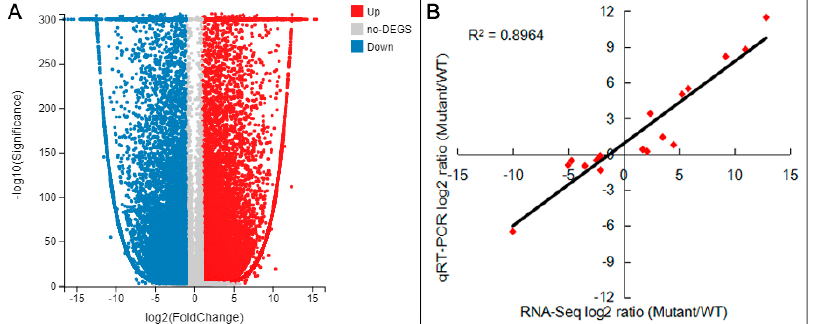
Figure 7. Analysis and validation of differentially expressed genes (DEGs) between ‘SO’ and ‘ZH’. ( A ) Volcano plot of DEGs. The X axis represents log2 transformed fold change; the Y axis represents -log10 false discovery rate, the red points represent up-regulated DEGs, the blue points represent down-regulated DEGs and the gray points represent non-DEGs; ( B ) correlation of gene expression results obtained from RNA-seq (X axis) and quantitative real-time polymerase chain reaction (qRT-PCR) (Y axis) analysis. Correlation assay performed for 18 DEGs with log2 ratio ≥ 1.00 or ≤ − 1.00.